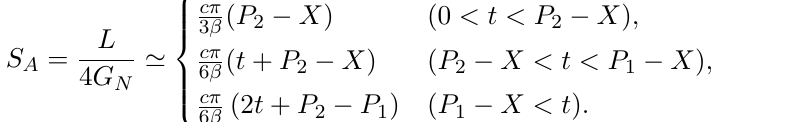
where we omit a constant term 1